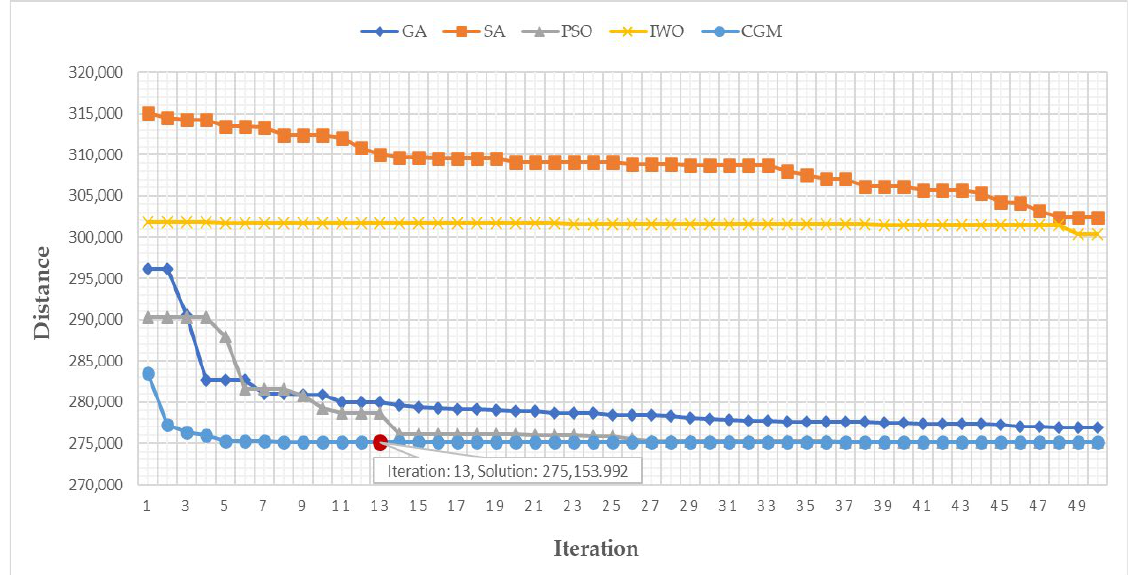
Figure 10. Investigation of convergence in different algorithms for the optimal-placement-of-resources problem (the number of devices was 5000 in a 10-dimensional space).